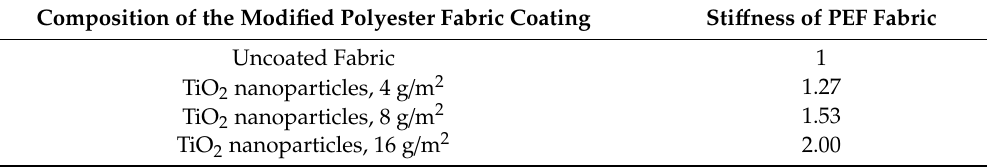
Table 1. The sti ff ness of TiO 2 -coated PEF